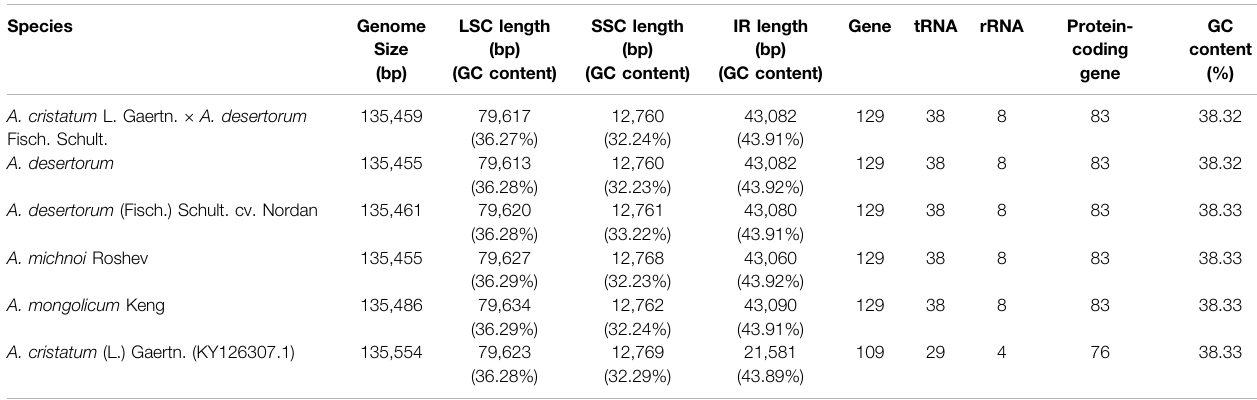
TABLE 2 | Comparison of the chloroplast genome features of fi ve Agropyron